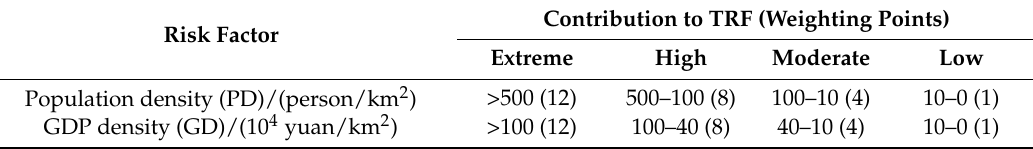
Table 3. Definition of dam size risk